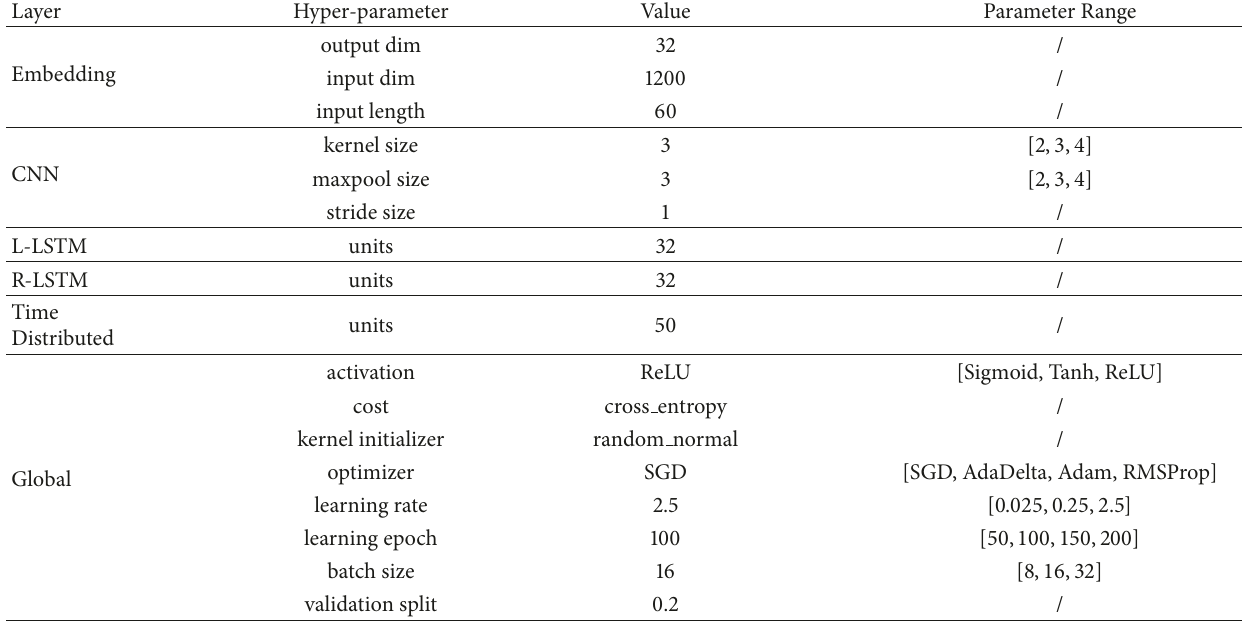
Table 1: Hyperparameter